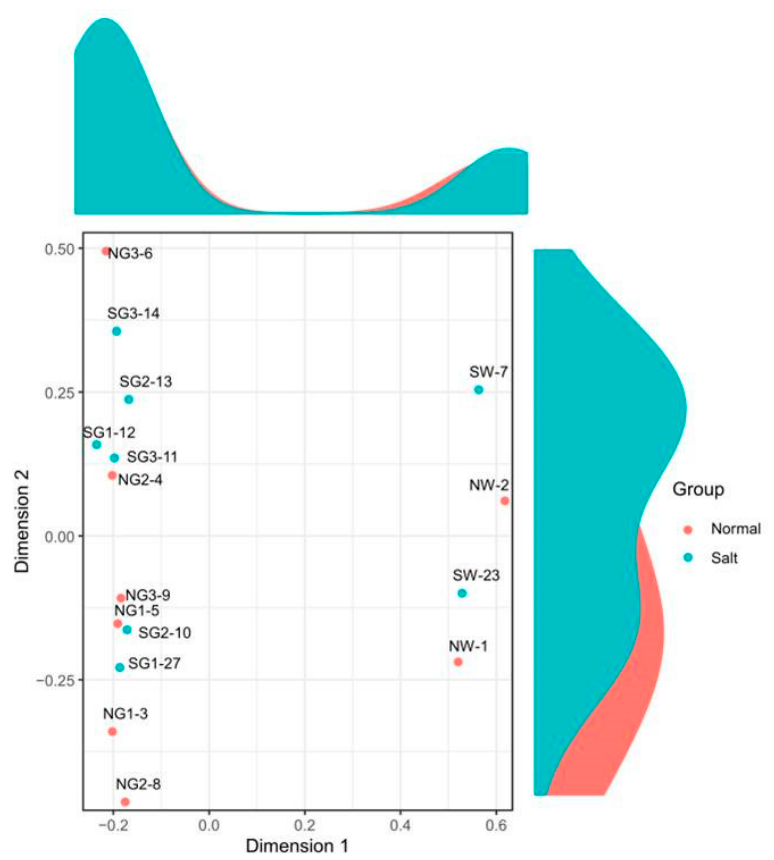
Figure 4. Multi-dimensional scaling (MDS) plot based on the transcriptomic analysis of wild-type rice plants and transgenic rice plants overexpressing PsGAPDH . Each point represents an RNA-seq sample. “Normal” and “Salt” groups are illustrated. Table 1. Log-fold changes of top 10 down-regulated DEGs and top 10 up-regulated DEGs in Normal sample vs. PsGAPDH transgenic sample. Table 1 contains top 10 down-regulated DEGs and top 10 up-regulated DEGS with an adjusted p -value < 0.05.